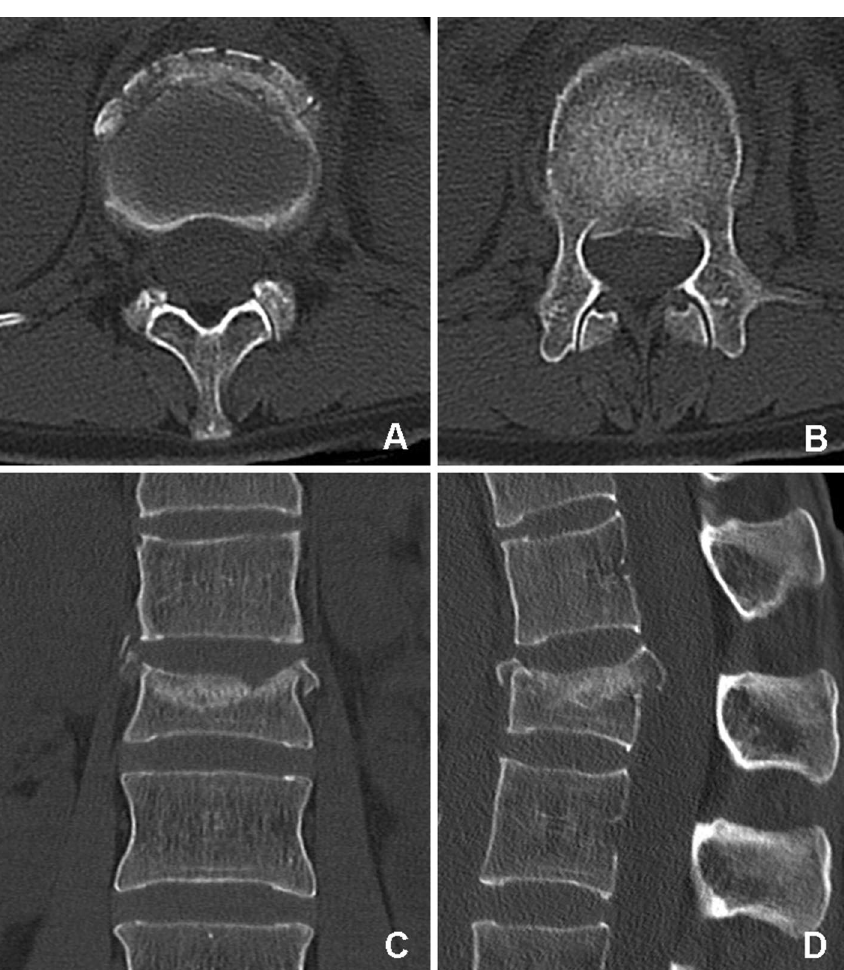
A3.1.1, AOSpine A3 1 , load sharing classification score 7 3 ) of L1 sustained in a car accident. CT scans showing representative axial ( A and B ), coronal ( C ) and sagittal ( D ) slices of the thoracolumbar junction. The upper half of the vertebral body was partially comminuted with centrifugal extrusion of fragments. Fragments of the posterior wall are retropulsed into the spinal